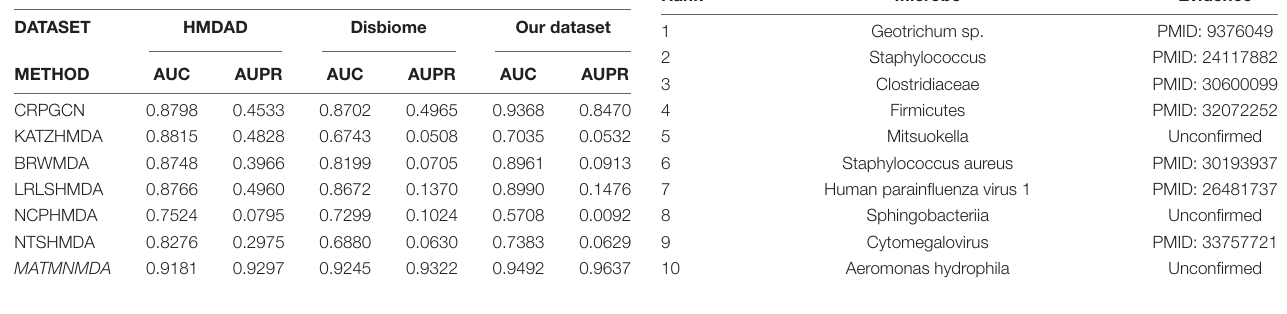
TABLE 1 | Performance comparison of MATMNMDA and baselines on different